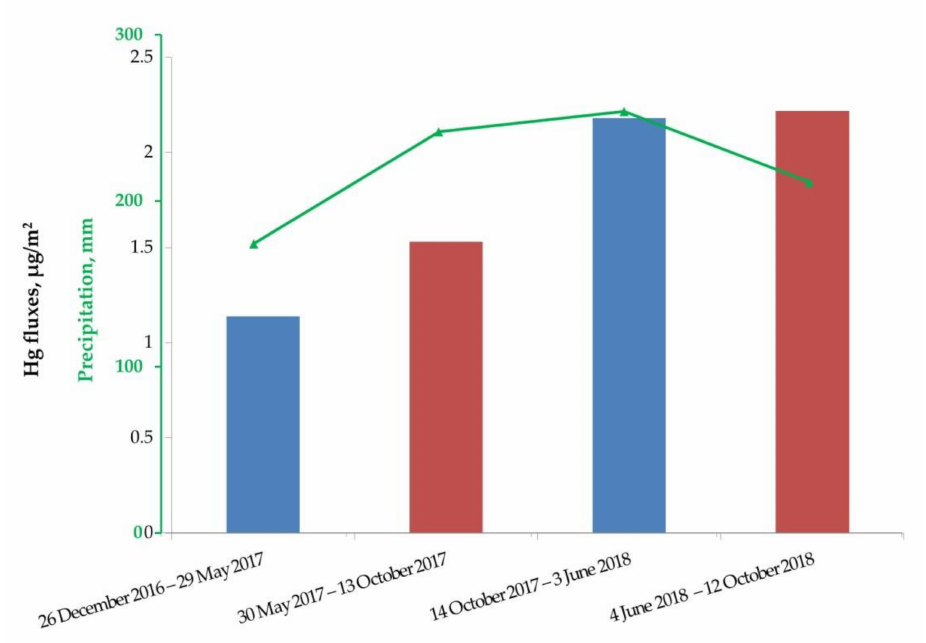
Figure 5. Seasonal atmospheric wet precipitation in Nadym (mm, green triangles) and fluxes of Hg wet deposition ( µ g/m 2 , red and blue colors correspond to warm and cold periods,